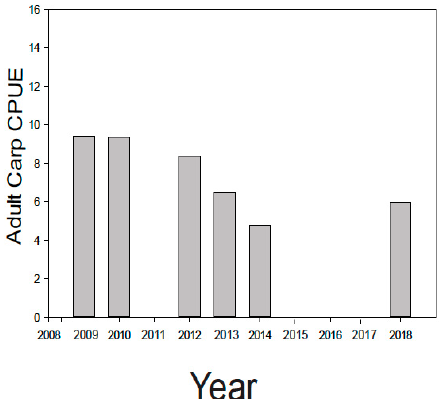
Figure 4. Average number of adult carp caught electrofishing per hour (CPUE) across lakes Kohlman, Gervais and Keller (data are combined and averaged). The study started in 2009.